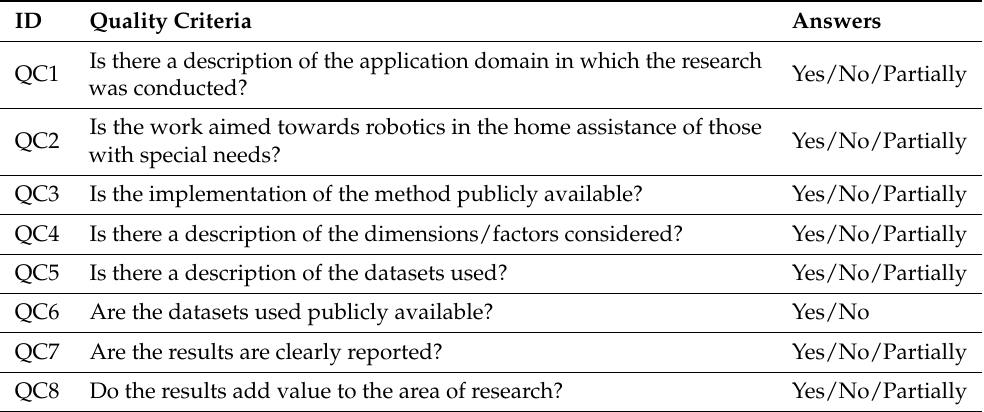
Table 4. Quality assessment criteria and possible